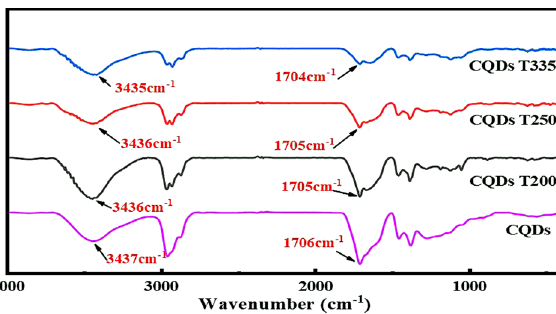
Figure 2: TEM images of